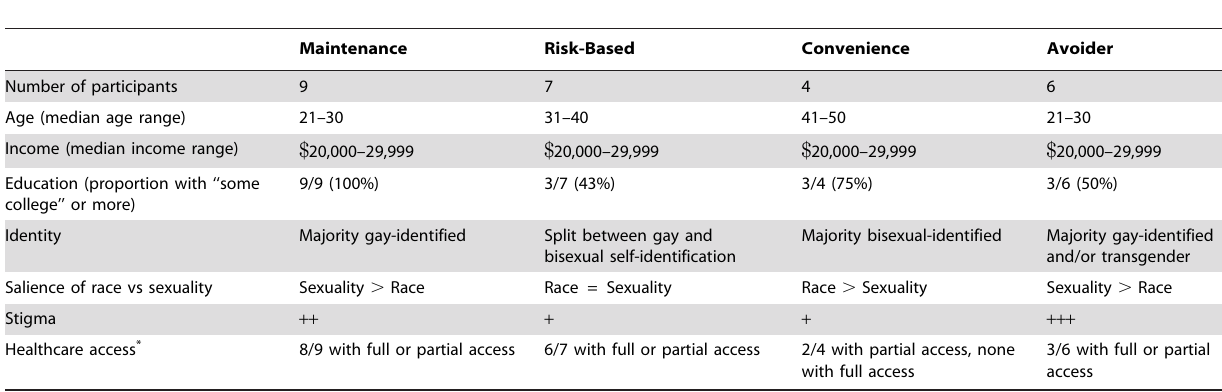
Table 2. Characteristics of Interview Participants in the Four Testing